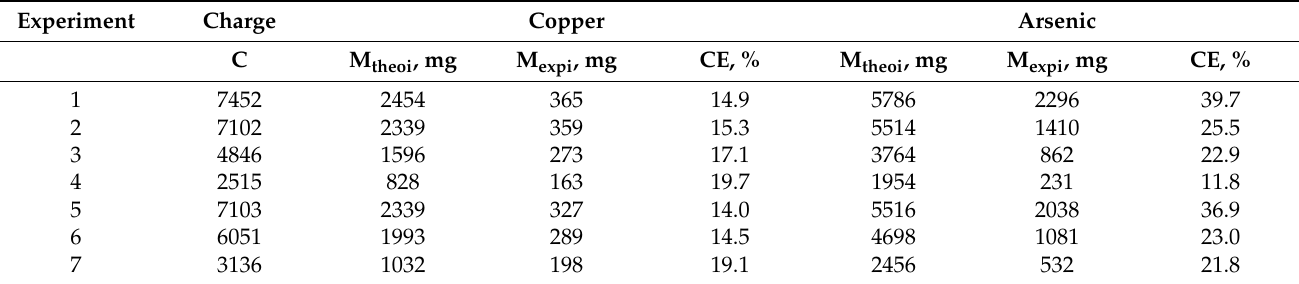
Table 3. Current efficiency with respect to copper and arsenic